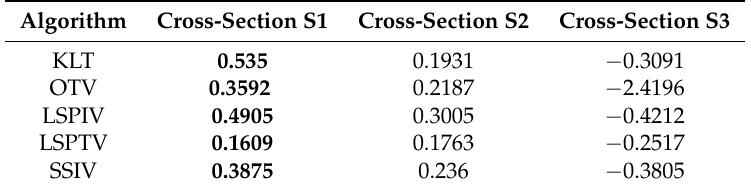
Figure 9. Cross-sectional analysis of Video B processed with all algorithms against the ADCP data. The left panels represent three different cross-sections (( A = S1, C = S2, and E = S3), the right panels represent the difference from the ADCP of the three cross-sections ( B = S1, D = S2, and F = S3). The distance across the channel relates to the y co-ordinates in Figures 2, 4 and 6. 5 m is the right bank, and 25 m is the left bank. Table 4. Nash–Sutcliffe results for Video A. Bold text represents the best recorded value for each algorithm.